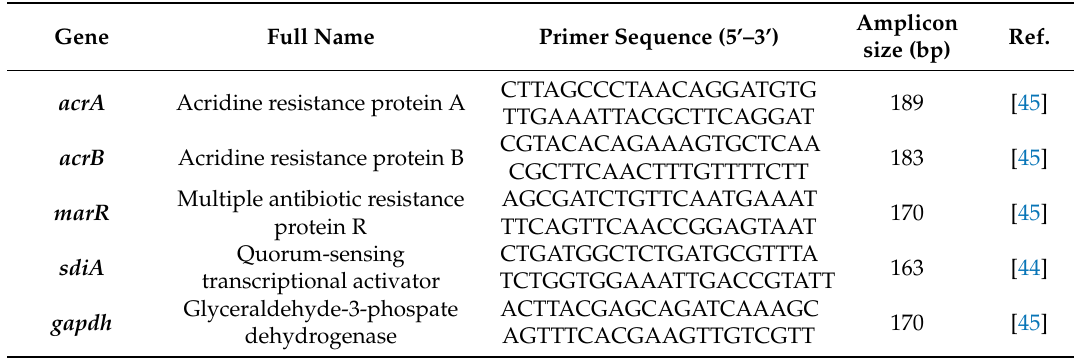
Table 5. Primers used in the